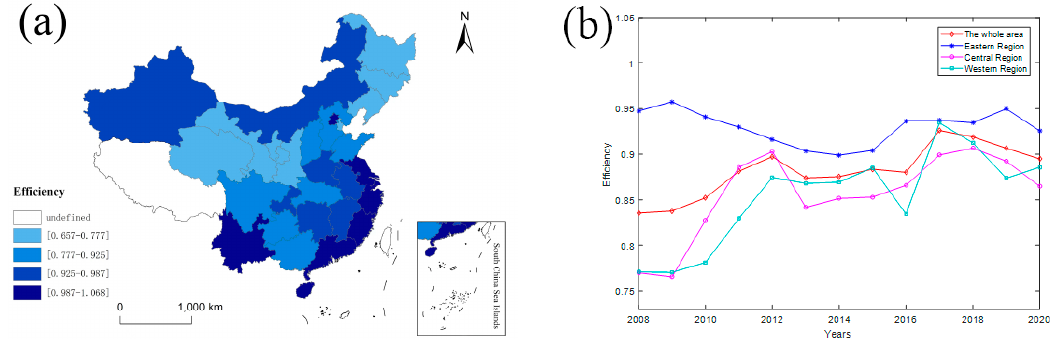
Figure 1. ( a ) The average level of ESDE in China; ( b ) the average level of ESDE in three regions. Data source: Table 2.